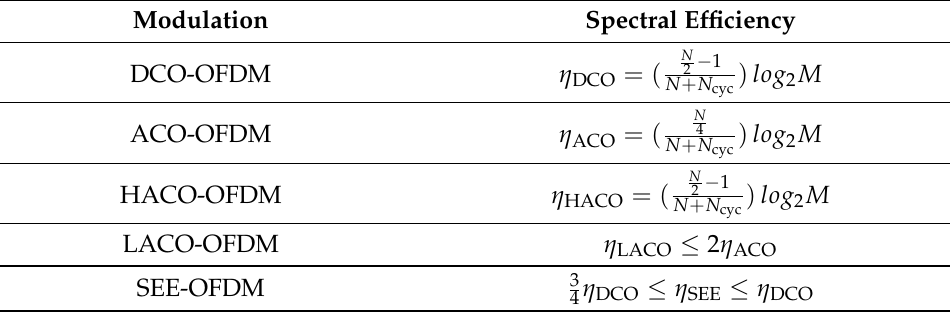
Table 2. Spectral efficiency of common VLC OFDM modulation